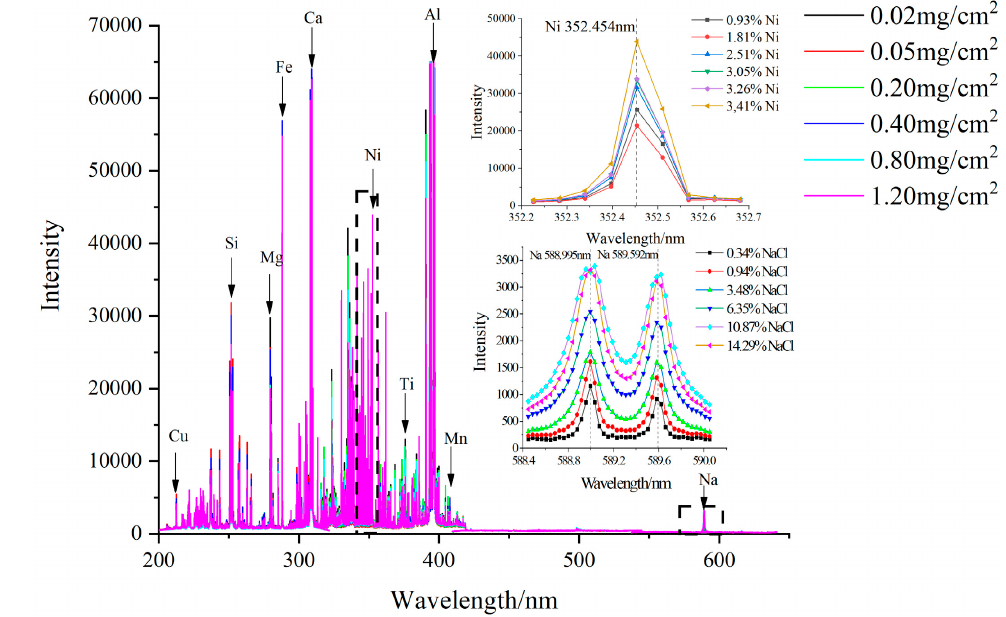
Figure 5. Spectral intensity distribution of different sampling points of Group 1.